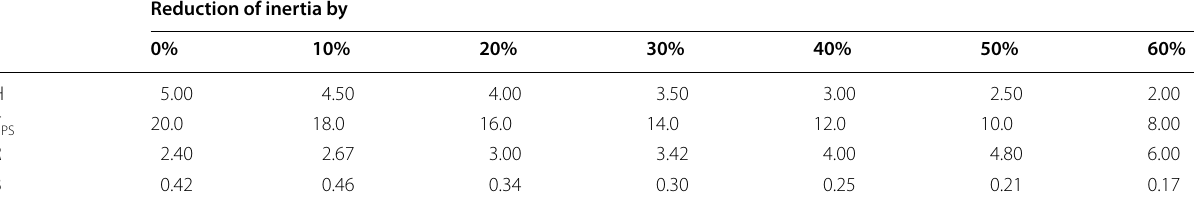
Table 4 Modified R, B, T when inertia is reduced by 0%, 10%, 20%, 30%, 40%, 50% and 60% in area PS